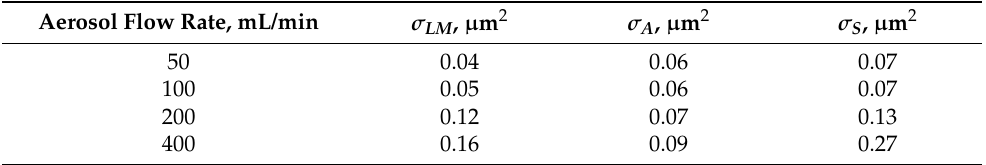
Table 2. Extinction cross-sections of laser-modified NPs, initial agglomerates, and thermally modified NPs at the wavelength of 527